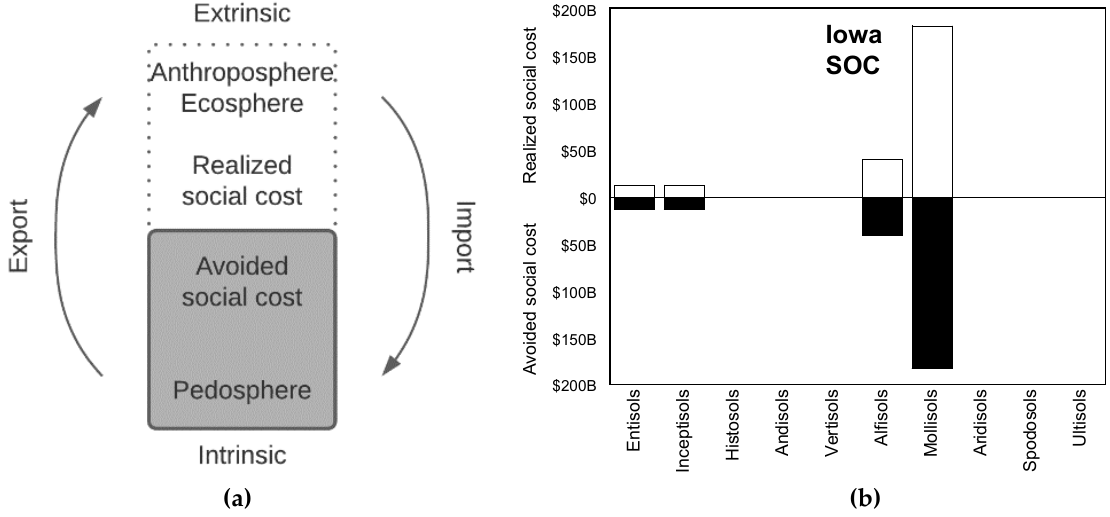
Figure 13. Relationship between intrinsic (e.g., avoided social costs) and extrinsic (e.g., realized social costs) estimates of social costs associated with pedosphere in general ( a ), and using the state of Iowa and soil organic carbon (SOC) as an example ( b ) based on midpoint SOC numbers from Guo et al., 2006 [41] and a social cost of carbon (SC-CO 2 ) of $42 (USD) per metric ton of CO 2 [51].